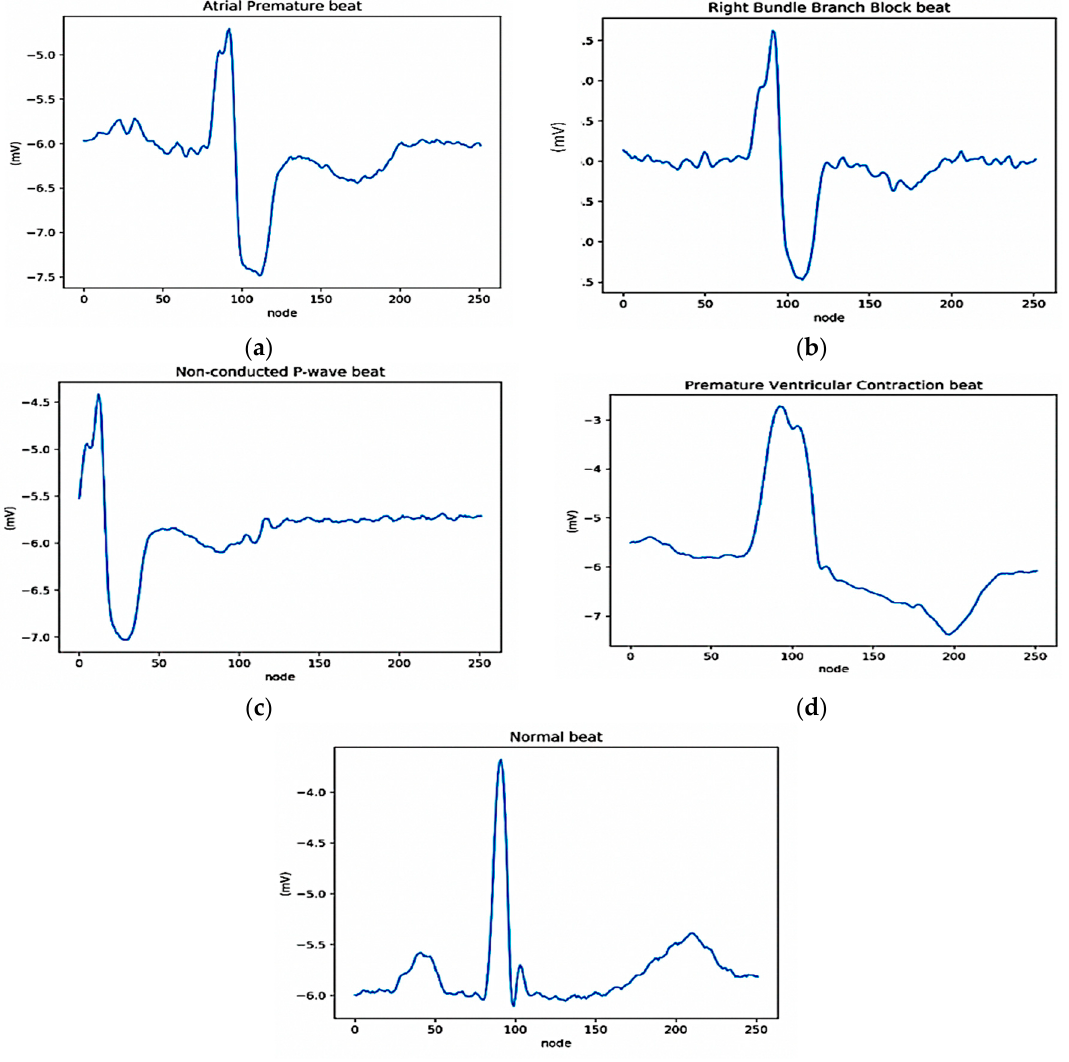
Figure 4. Heartbeat segmentation result. ( a ) Beat 959 label A (record 118), ( b ) Beat 72 label R (record 118), ( c ) Beat 2018 label P (record 118), ( d ) Beat 2323 label V (record 119), ( e ) Beat 2320 label N (record 119).